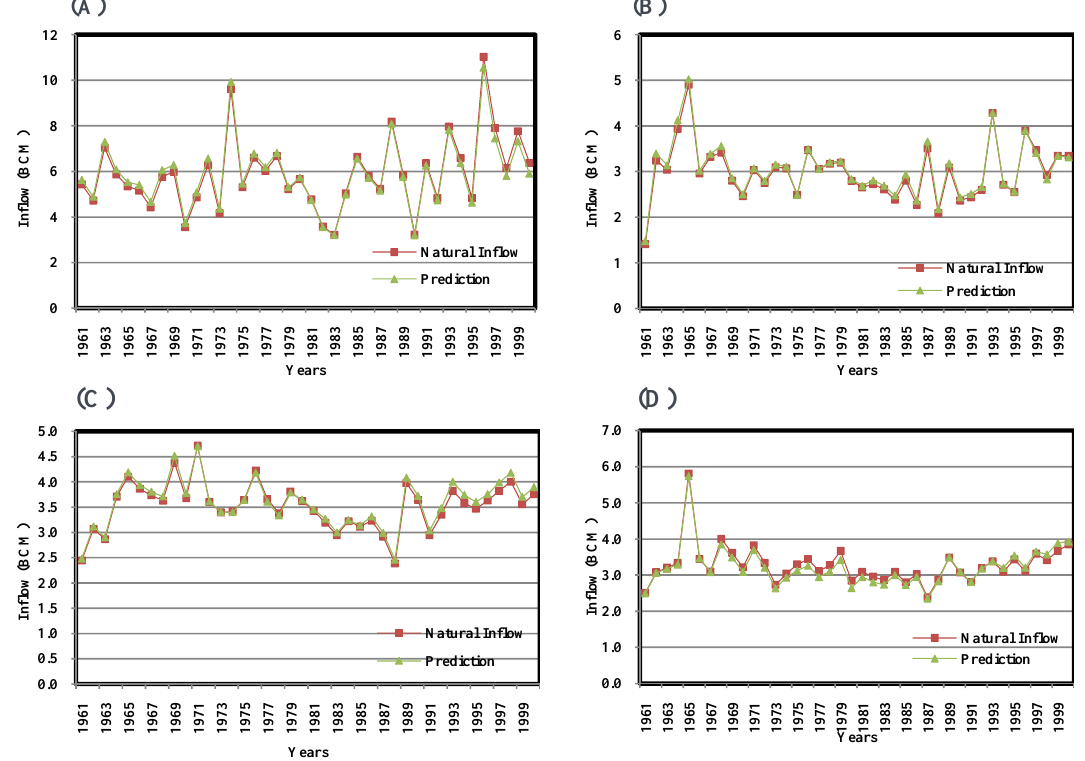
Fig. 17. Observed versus predicted values for (a) July (b) June (c) May (d) March with one month lag time. On the other hand, while using the second approach, for the first multi-lead ahead, identical level of RMSE errors are achieved as the predictor pattern are the same. For the same example for the month of November, for second multi-lead ahead, the RMSE is equal to 0.1441 BCM when the moni- tored inflows of August and September and the forecasted in- flow of October are used as shown in the fourth column. Fur- thermore, the RMSE has further increased to 0.1561 BCM when the monitored inflow of August and the forecasted in- flows of September and October are used as shown in the fifth column. In addition, it can be depicted that the sec- ond approach outperformed the first approach for most of the months except April, May and June, however, the change RMSE values are not significant. This is due to the fact that these months are considered as the dry period and might ex- perience slow decay in the cross-correlation with the previ- ous months. This is confirmation that, for multi-lead fore- casting, it might be better to utilize the forecasted values with a certain level of error, but highly correlated with the output as a predictor rather than utilizing actual values which are not correlated and a higher order with the